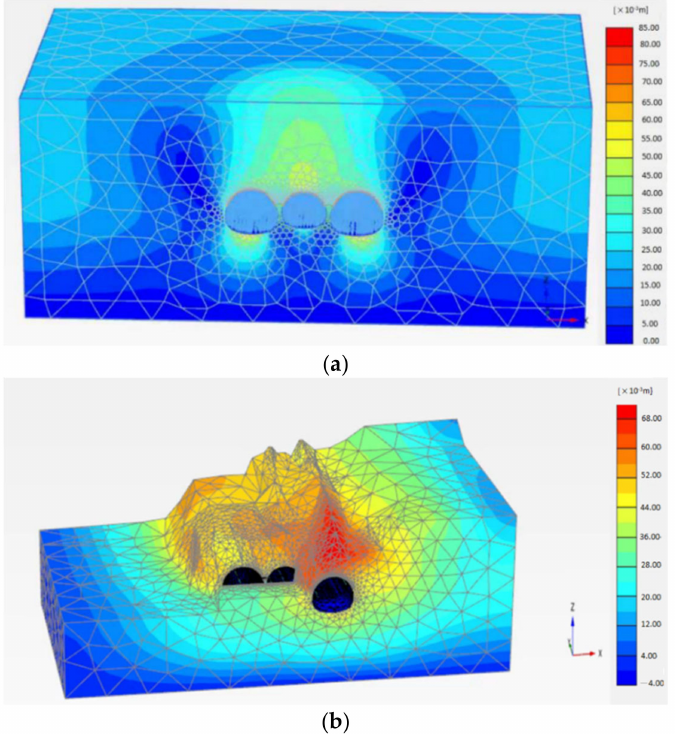
Figure 18. Shading distribution diagram of the total displacement of tunnels: ( a ) unbiased case and ( b ) biased